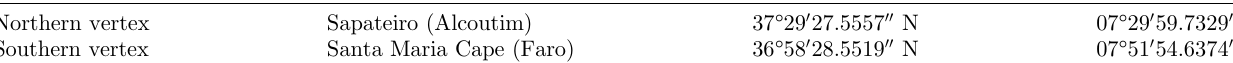
Table 3. Upper and lower parallels of the LCC map projection for Algarve.